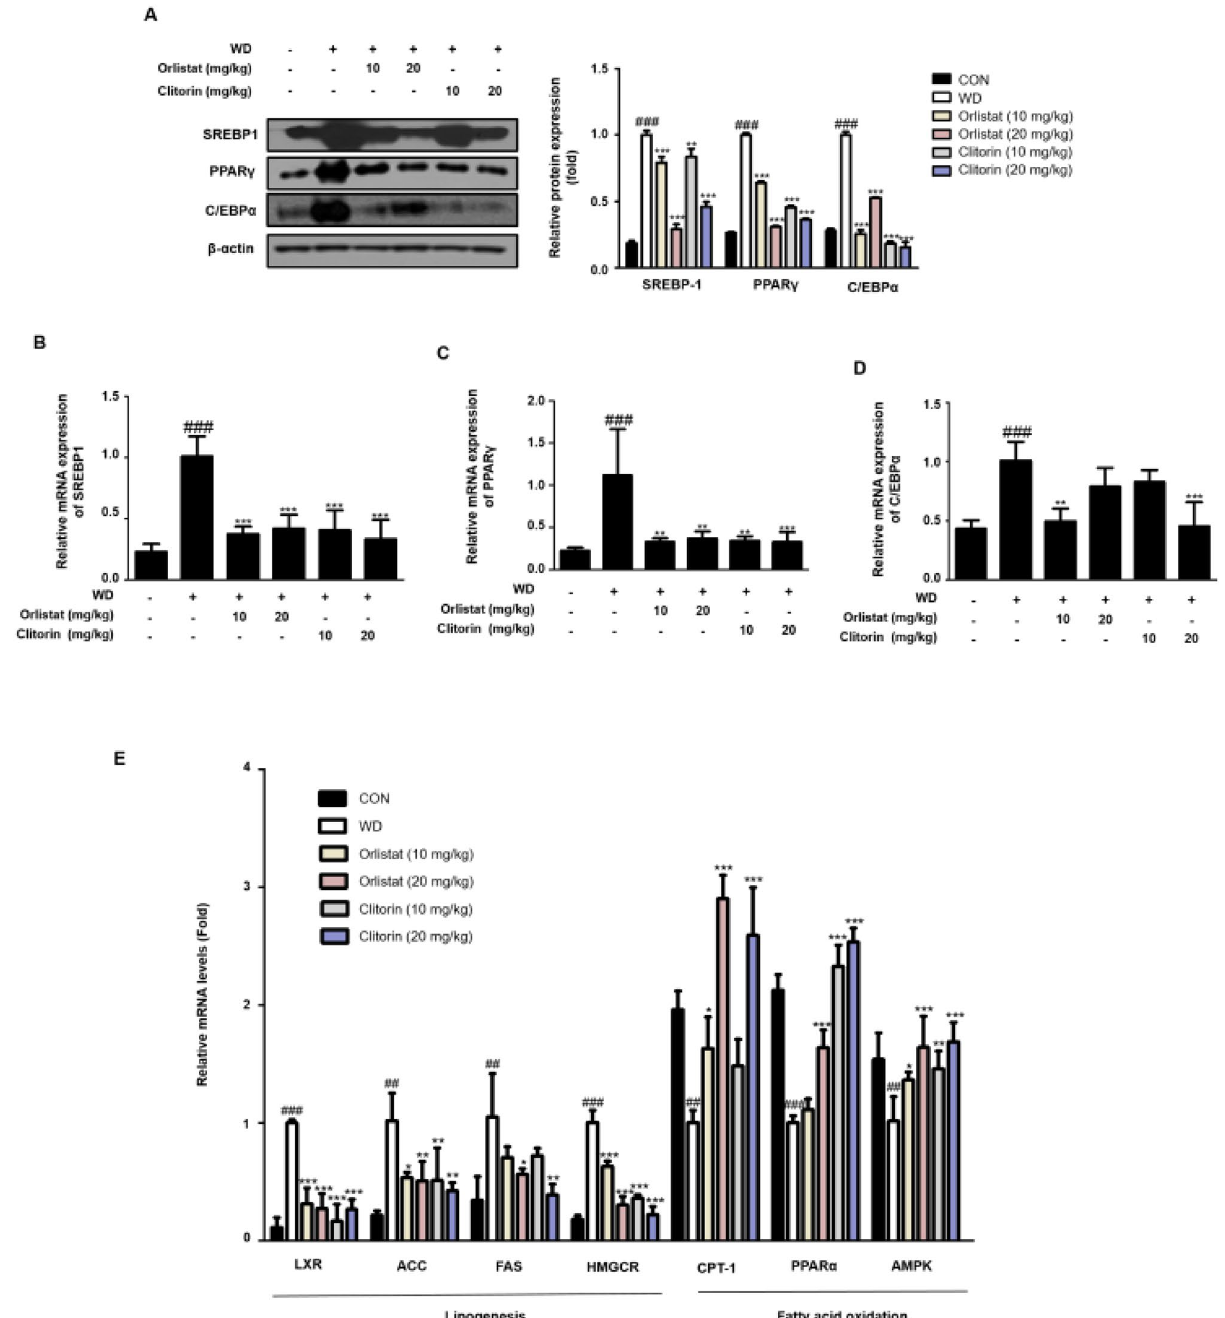
Figure 4. Effect of clitorin on adipogenic, lipogenic, and fatty acid oxidation-related genes in the liver of WD-induced hepatic steatosis mouse model. The protein levels of ( A ) SREBP1, PPARγ, and C/EBPα were determined using western blot analysis. The cropped gel images are shown for clarity. Densitometric analysis was performed using ImageJ ver. 1.50i (https:// imagej. nih. gov/ ij/). The mRNA levels of ( B ) SREBP1 , ( C ) PPARγ , ( D ) C/EBPα , and ( E ) LXR , ACC , FAS, HMGCR, CPT-1 , PPARα , and AMPK were determined using qRT-PCR analysis. The values are represented as the mean ± SD (n = 6 per group). # P < 0.05, ## P < 0.01,